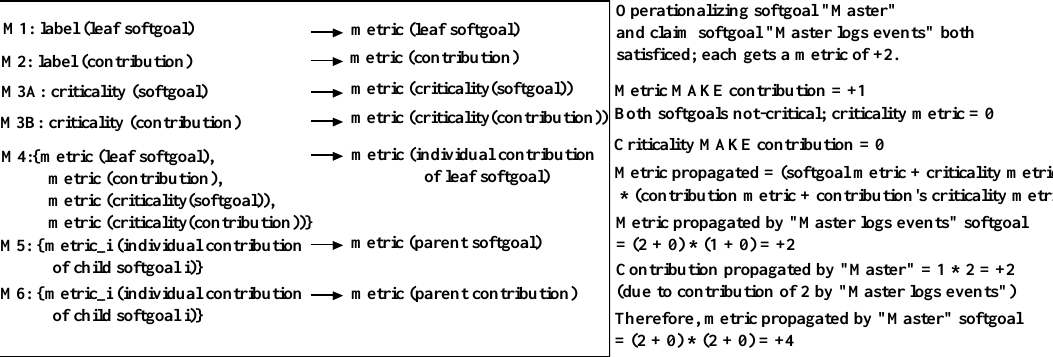
Figure 18. Mapping qualitative aspects of SIG to a quantitative evaluation scheme ( left ) and example of single-value quantitative scheme calculation ( right ).